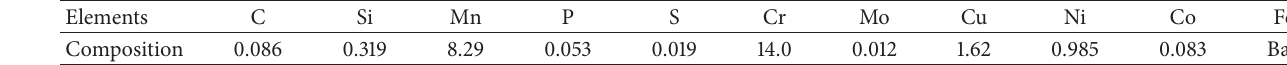
Table 1: The mild steel alloy components (wt.%).